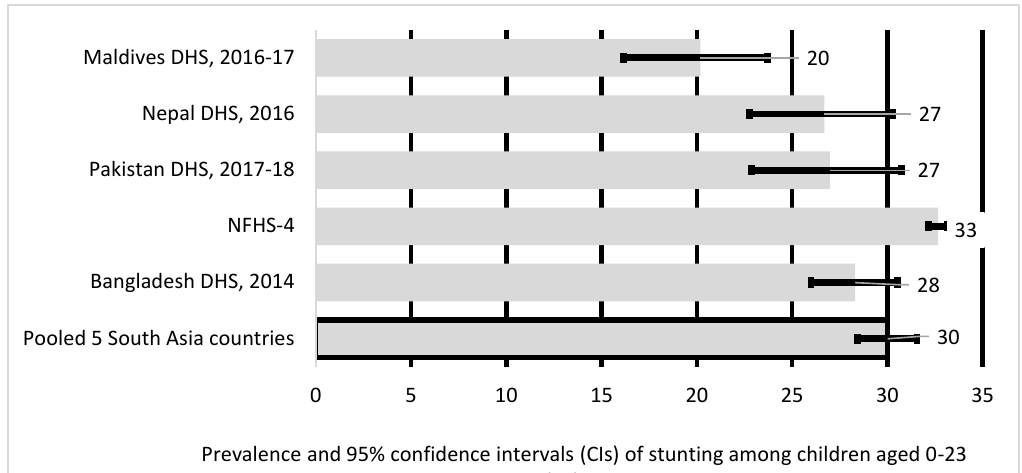
Figure 2. Prevalence and 95% confidence intervals of stunting in children aged 0–23 months in South Asia.